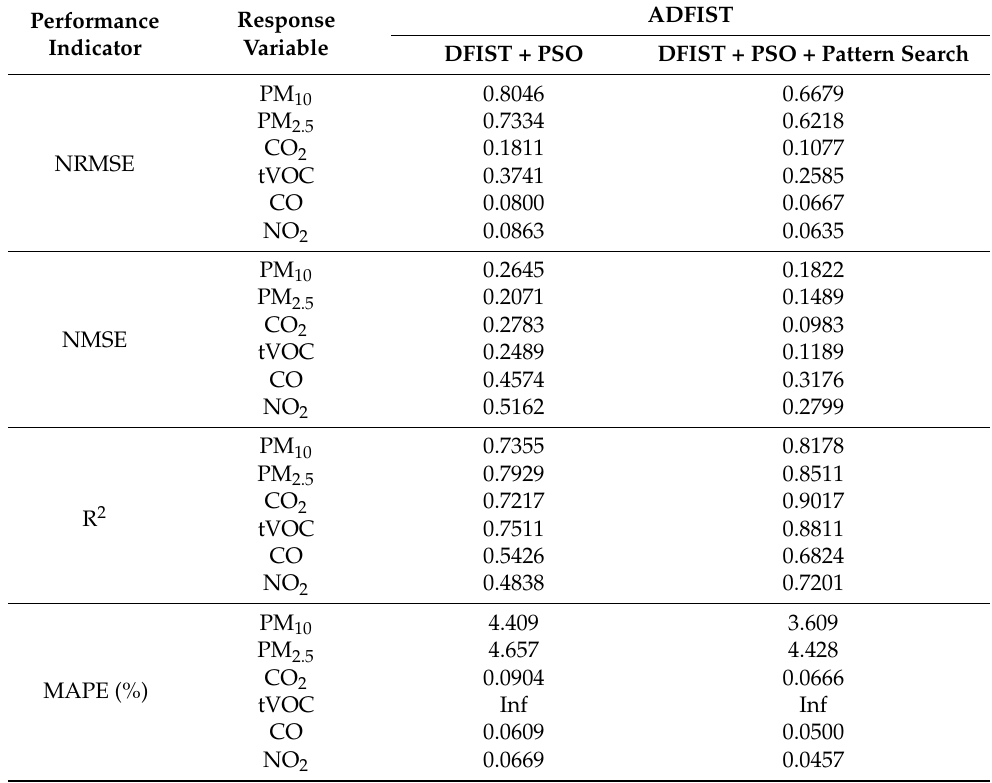
Table 6. NRMSE performance of ADFIST after PSO based rule learning and pattern search-based